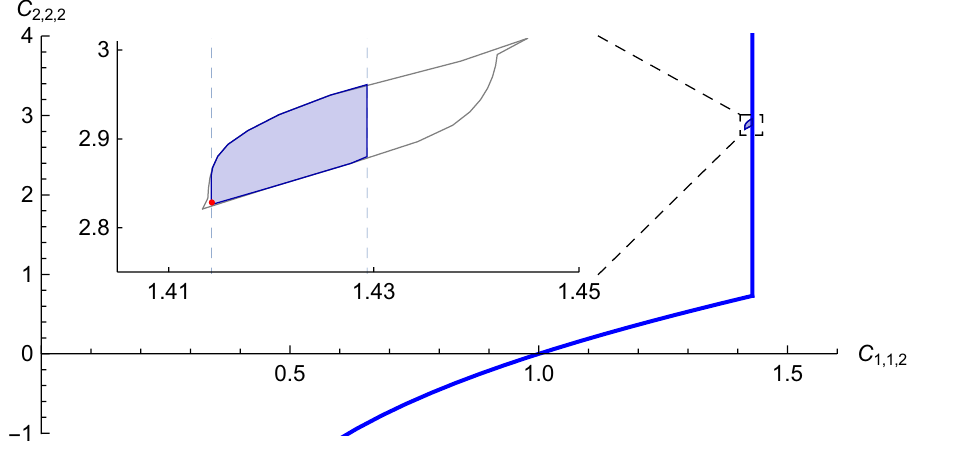
Figure 12 . Allowed region for the OPE coe(cid:14)cients C 1 ; 1 ; 2 and C 2 ; 2 ; 2 for the gaps (cid:1) (cid:1) = 5, (cid:1) = 4 and (cid:1) = 3. The allowed region is shaded in blue and is the result of [2 ; 0] [0 ; 2] [0 ; 1] intersecting the numerics for the mixed system done for (cid:3) = 40 with the bound 1 : 414 (cid:20) C 1 ; 1 ; 2